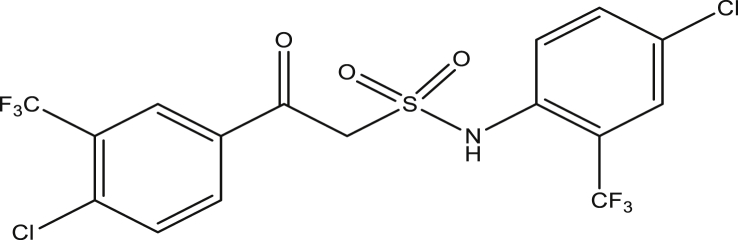
Compound 9a [N-(4-chloro-2-(trifluoromethyl)phenyl)-2-(4-chloro-3-(trifluoromethyl)phenyl)-2-oxoethanesulfonamide (pEC500.6949857)].